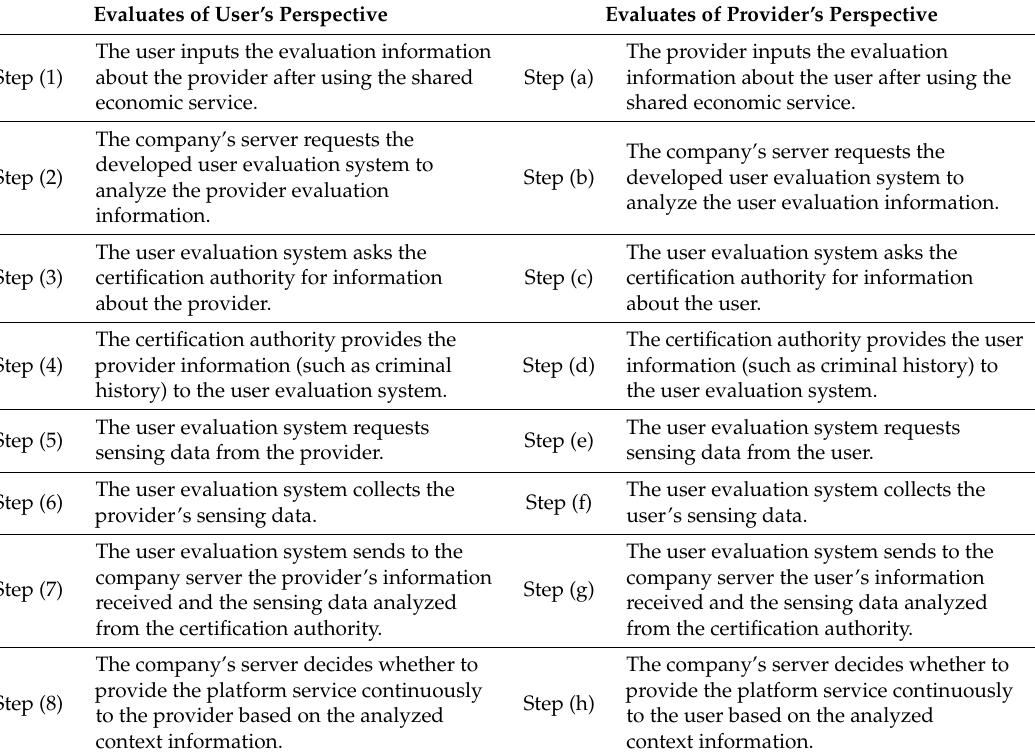
Table 3. Process of evaluation between providers and users in the system.